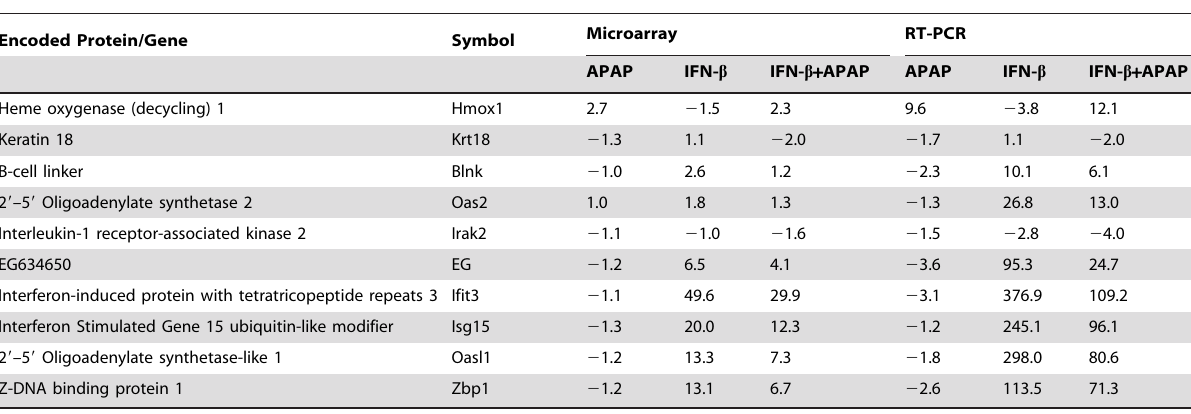
Table 3. Confirmation of selected genes using RT-PCR.